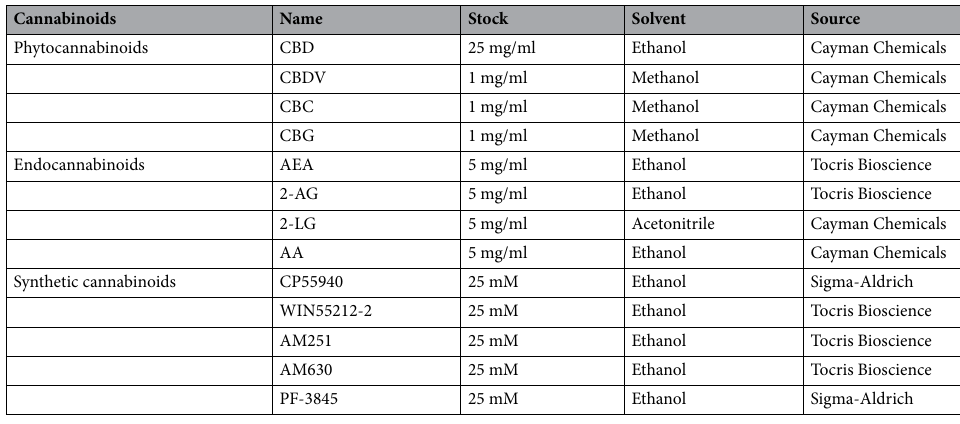
Table 1. Phytocannabinoids, endocannabinoids and synthetic cannabinoids used in this